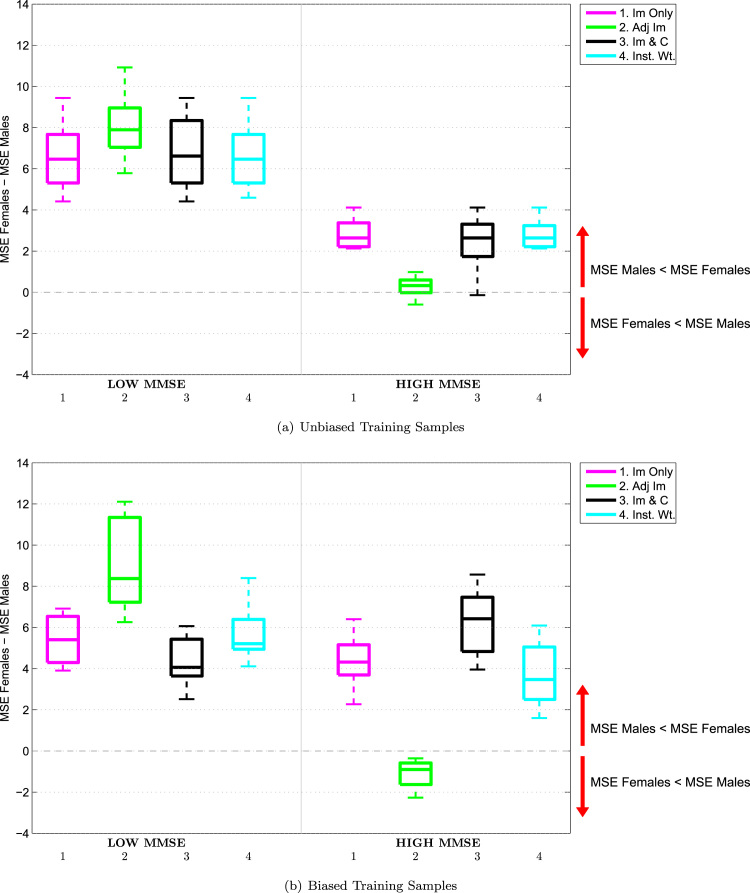
Signed difference between the MSE for females and MSE for males, over the different ranges of the MMSE Score. The data points in each box plot are the 8 predictions performed for a particular model. Results using unbiased training samples are shown in (a), while results using biased training samples are shown in (b). In the biased samples, males tend to have higher MMSE scores.